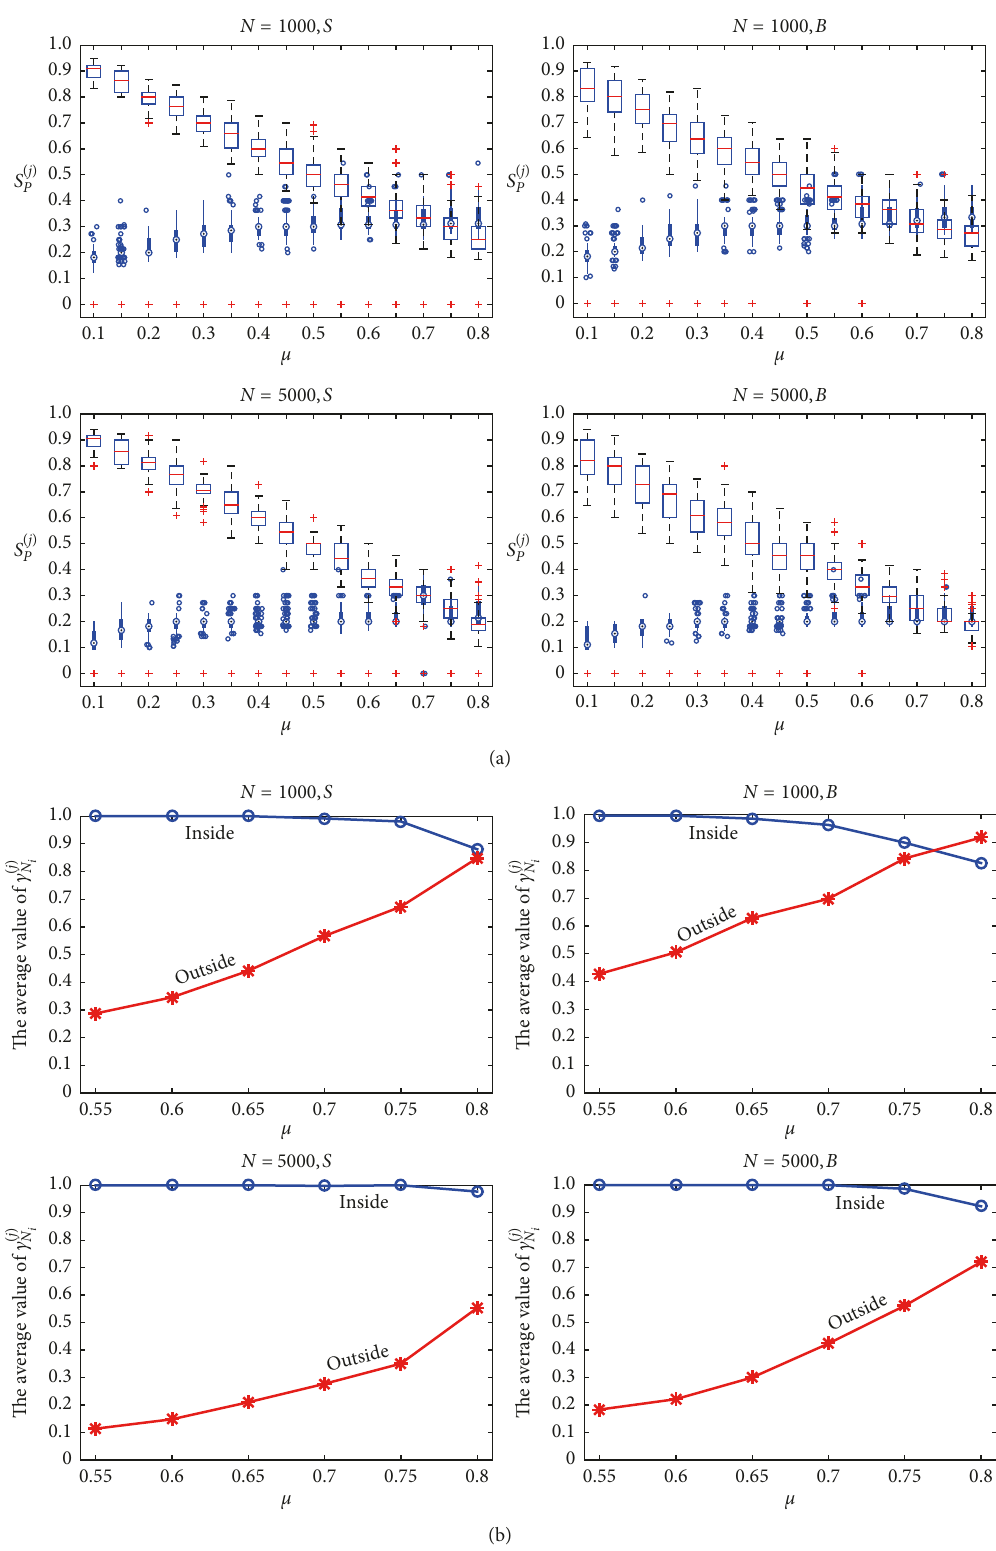
Figure 2: (a) We present the statistical results of S ( j ) P for different values of µ from 0.1 to 0.8. The detailed information about the size and scale of network structure is shown in Section 3. The hollow box plot is calculated from the hub nodes’ neighbors in the same community, and the solid blue plot is calculated from the hub nodes’ neighbors in other communities. Each test is conducted by 100 times. (b) We statistically for the neighbors inside and those outside the communities, respectively. Then, we get the mean values of compute the normalization form c ( j ) N i c ( j ) N i for each hub node i , where the blue lines are derived from the inside neighbors of the hub node and the red lines are from outside. In both (a) and (b), the letter S denotes communities of size between 10 and 50 while the letter B denotes communities of size between 20 and